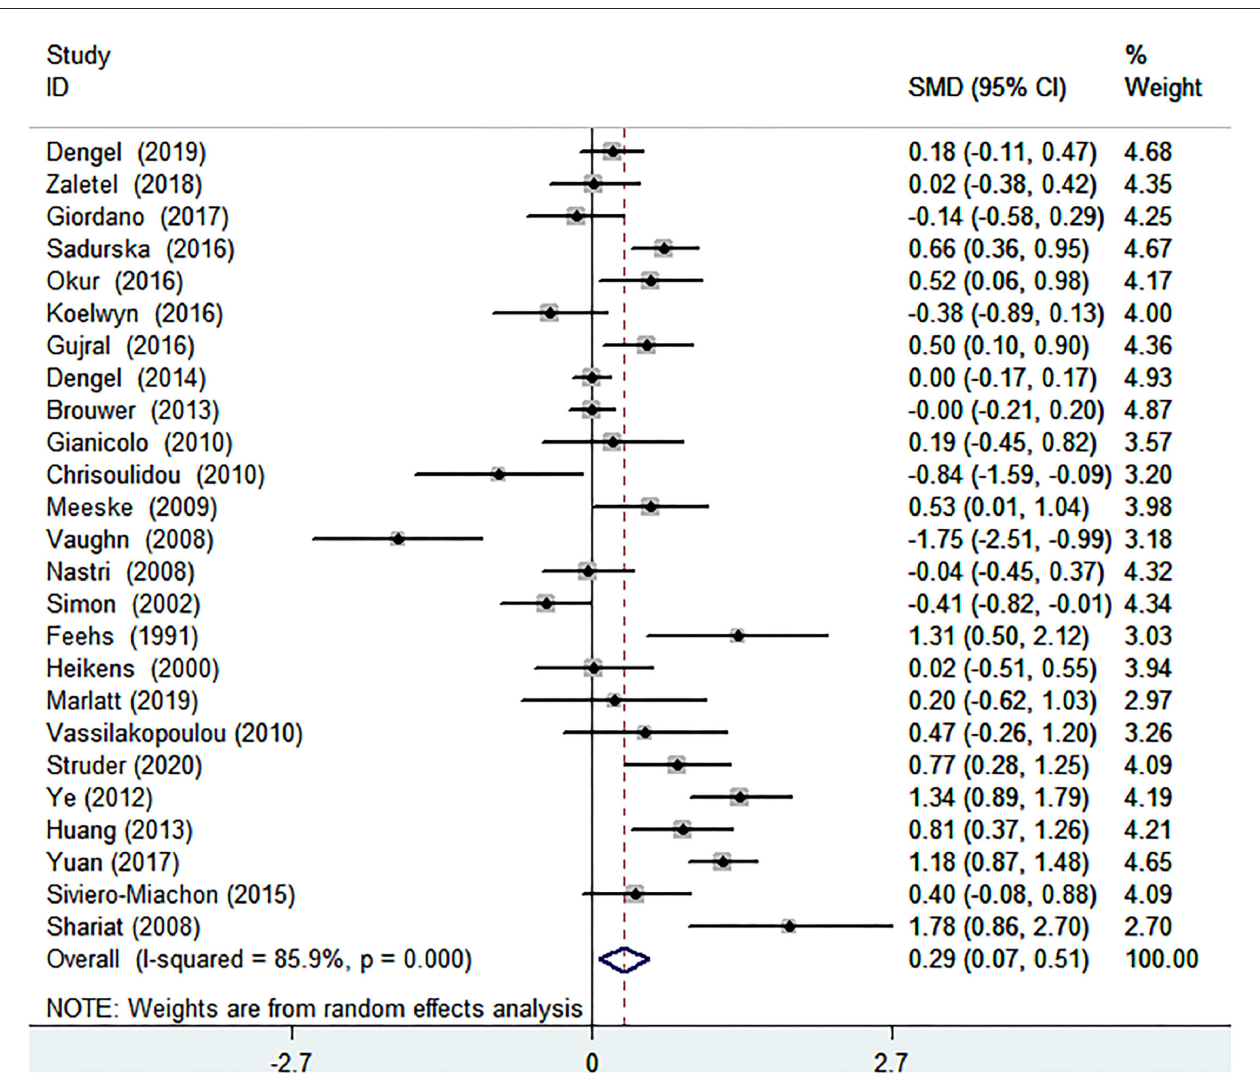
FIGURE 2 | Forest plot of intima-media thickness in patients with cancer and controls without cancer. SMD, standard mean difference; CI, confidence interval.